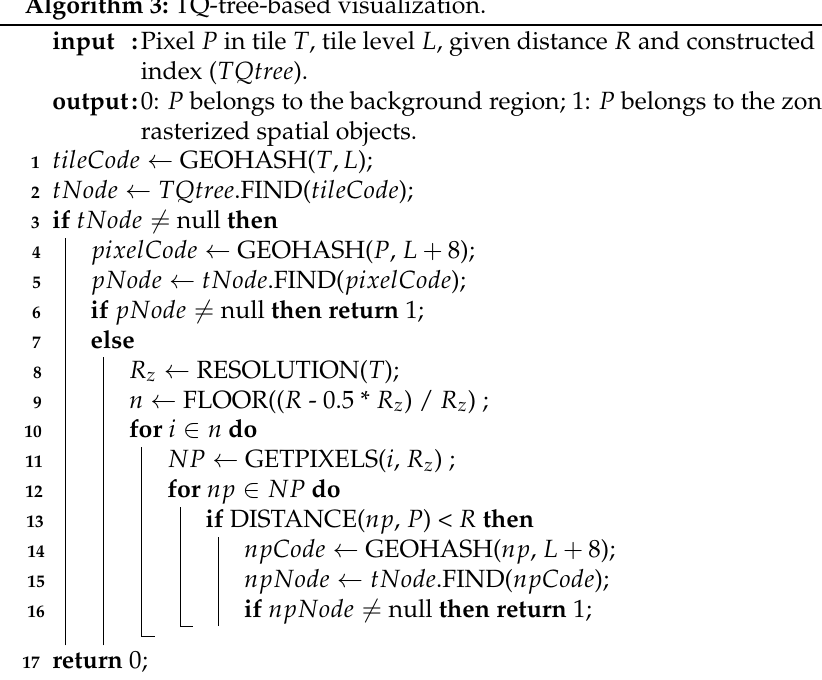
Algorithm 3: TQ-tree-based